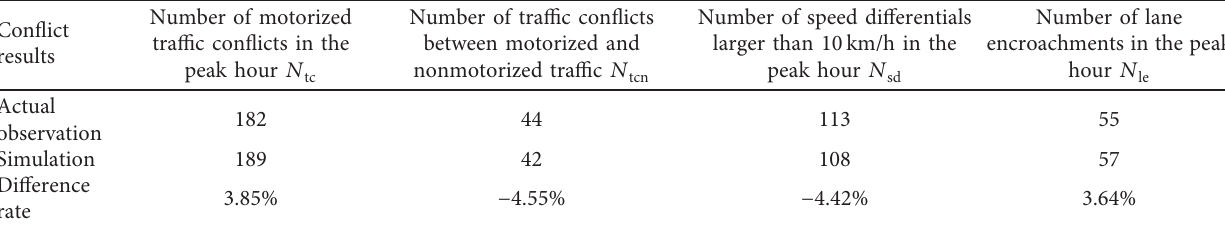
Table 9: Comparison of simulation and actual observation of driveway 1.